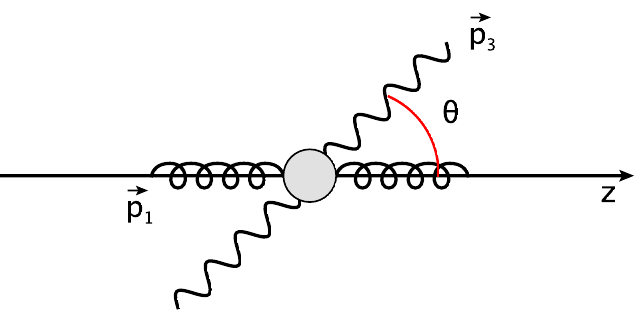
Figure 7. Illustration of the scattering angle θ between incoming momentum ~p 1 , parallel to the z -axis, and outgoing momentum ~p 3